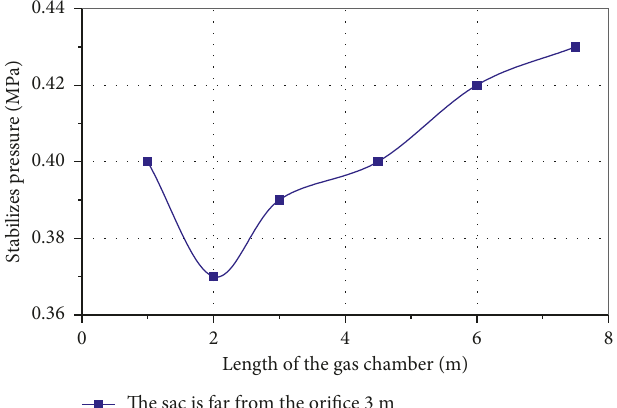
Figure 12: Effect of air chamber length on stable pressure when the sealing section is 3m from the orifice.